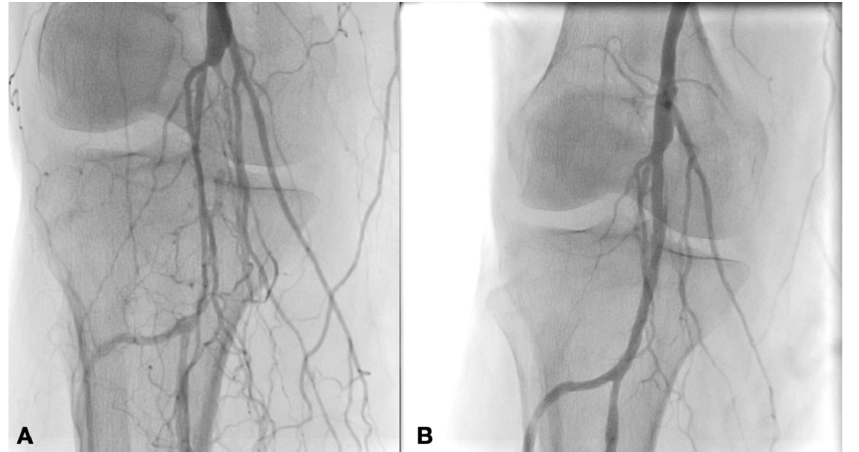
Figure 3. Intraoperative angiography showing popliteal artery before ( A ) and after PTA with Drug Eluting Balloon ( B ).